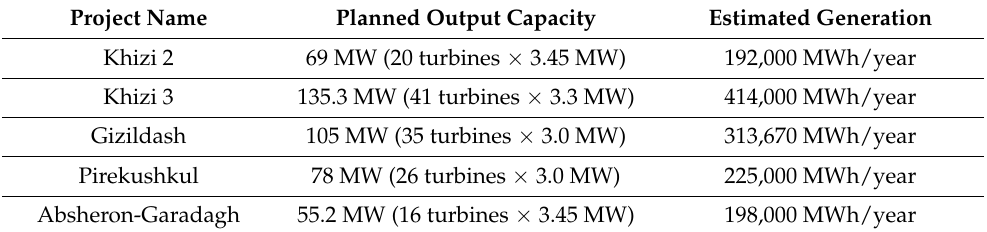
Table 12. Prospective WEPs projected by the Ministry of Energy of Azerbaijan [27,34].